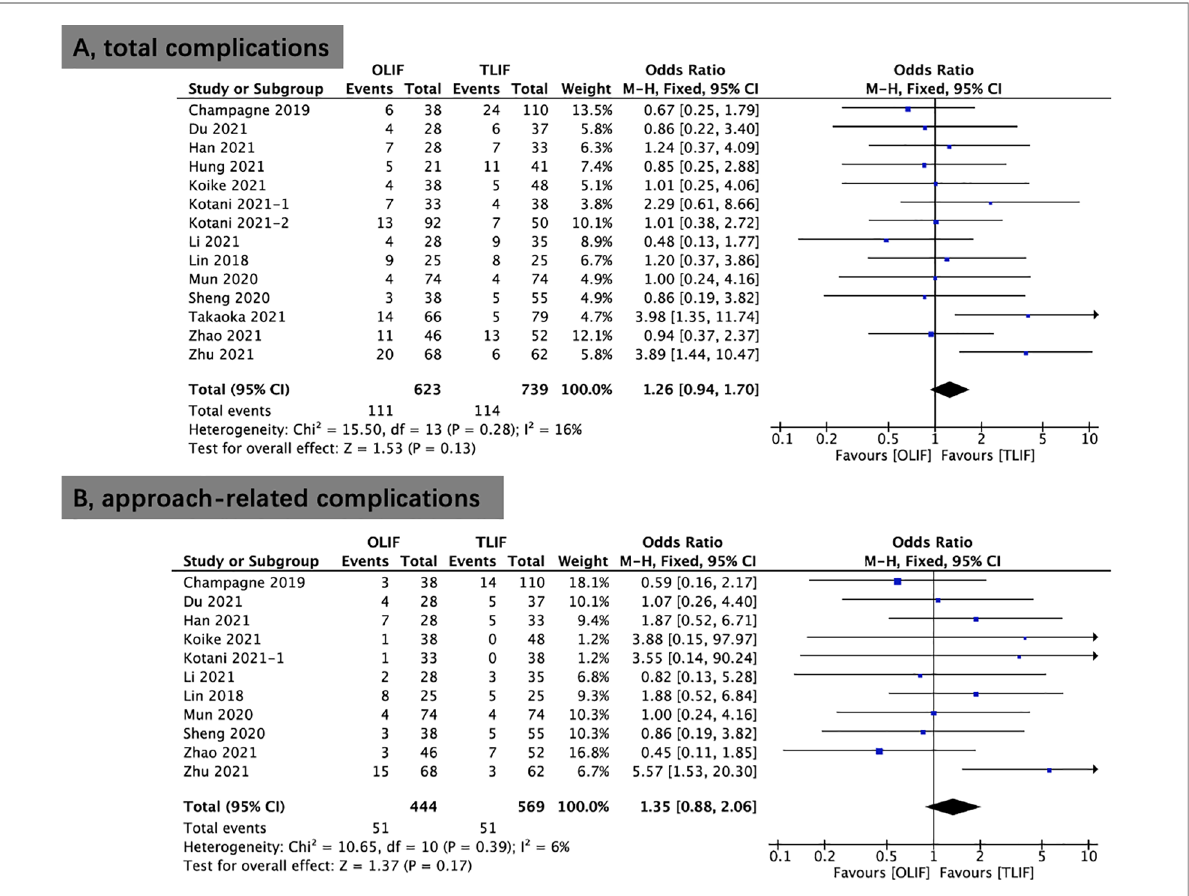
FIGURE 9 Forest plots comparing total complications ( A ) and approach-related complications ( B ) between OLIF and TLIF. OLIF, oblique lumbar interbody fusion; TLIF, transforaminal lumbar interbody